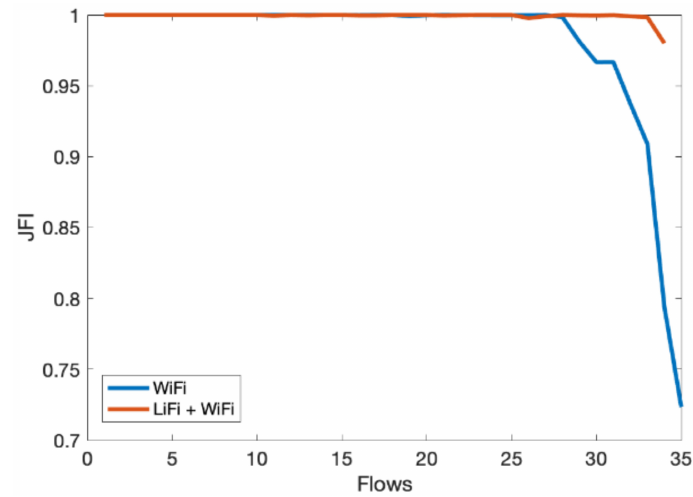
Figure 10. Jain’s fairness index (JFI) vs. number of flows.